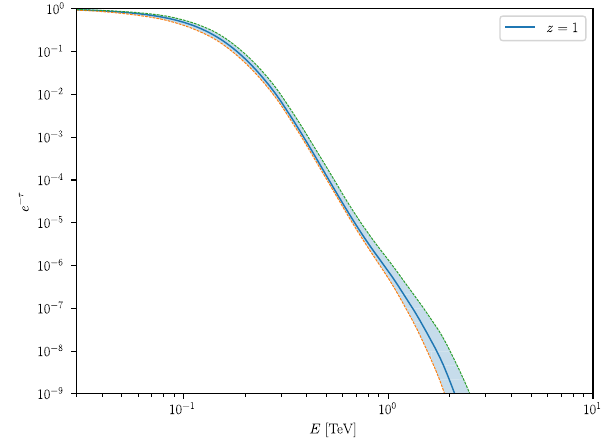
Fig. 7 The EBL attenuation ( e − τ ) of photons from a source with red- shift z = 1 . 0. The model and data are taken from Ref. [50] and http:// side.iaa.es/EBL/